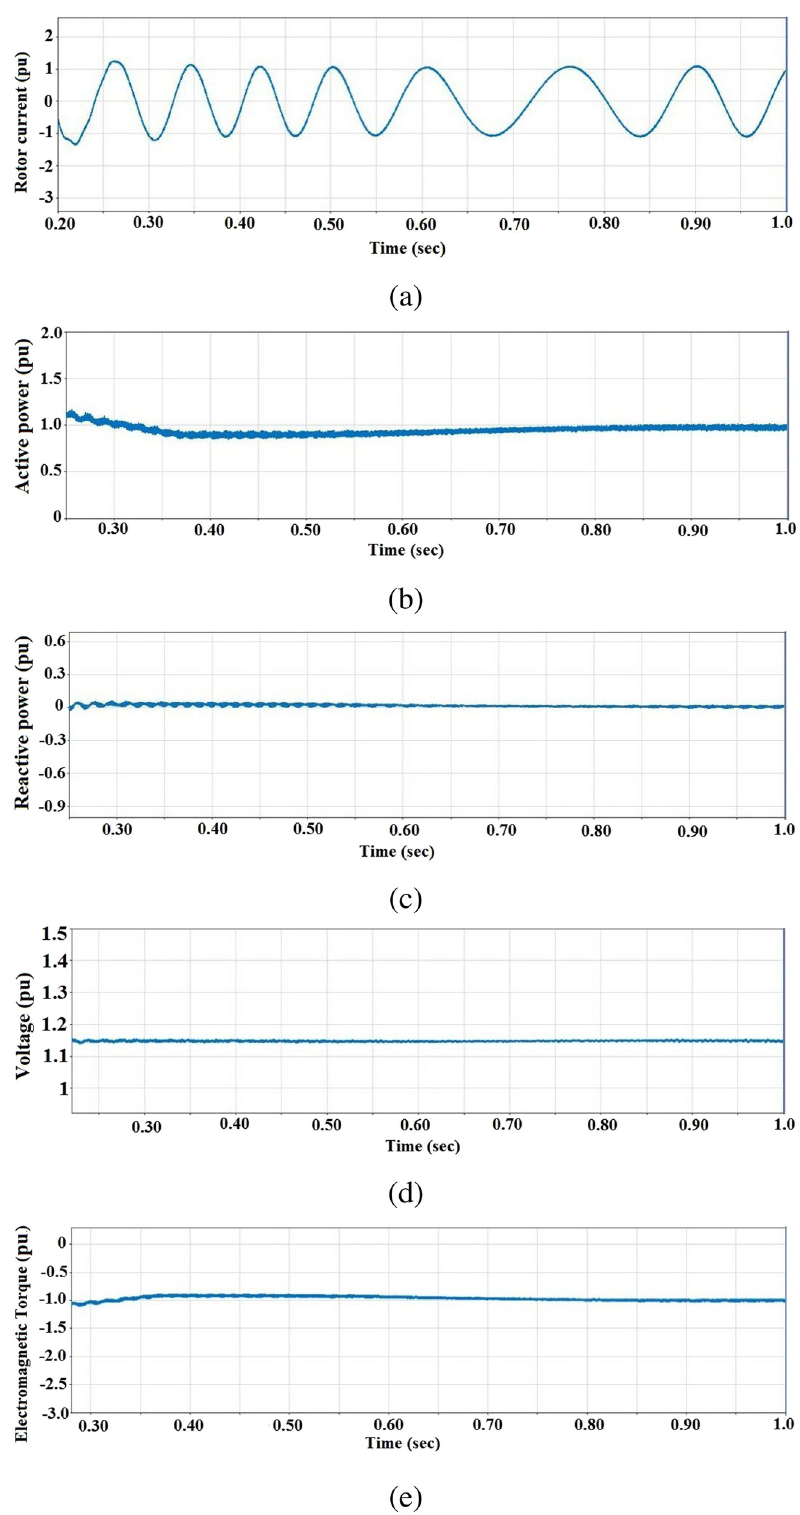
Figure 10: LVRT capability of DFIG without grid fault with the proposed controller: ( a ) rotor current, ( b ) real power, ( c ) reactive power, ( d ) DC - link voltage, and ( e ) electromagnetic